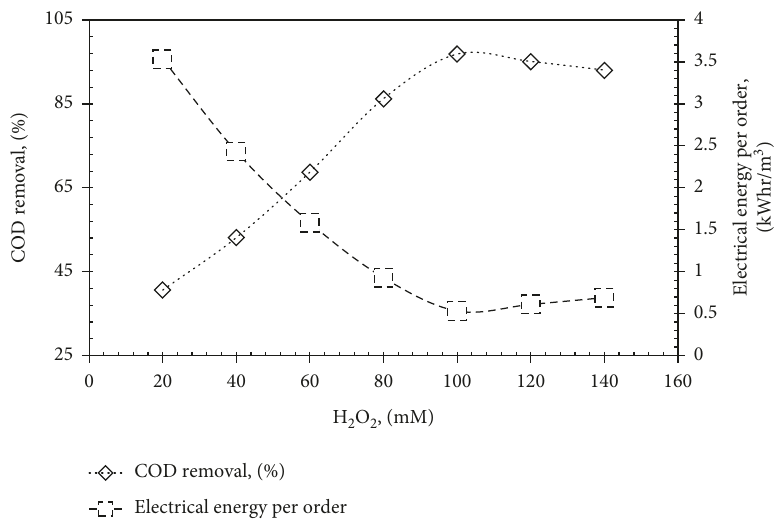
Figure 4: Effect of H 2 O 2 on % COD removal and EE/O in the O 3 /Fe time–4 h; O 3 flow rate and production–20 LPM and 4g/h; Fe 2+ –20 mM; and